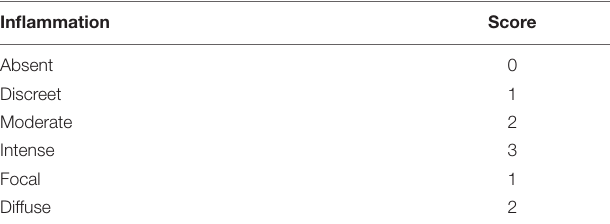
TABLE 1 | Inflammation scoring